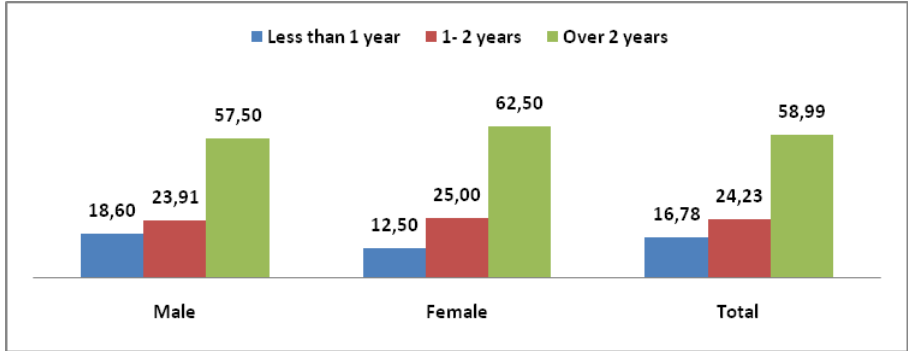
Source : TLMPS 2014 and authors’